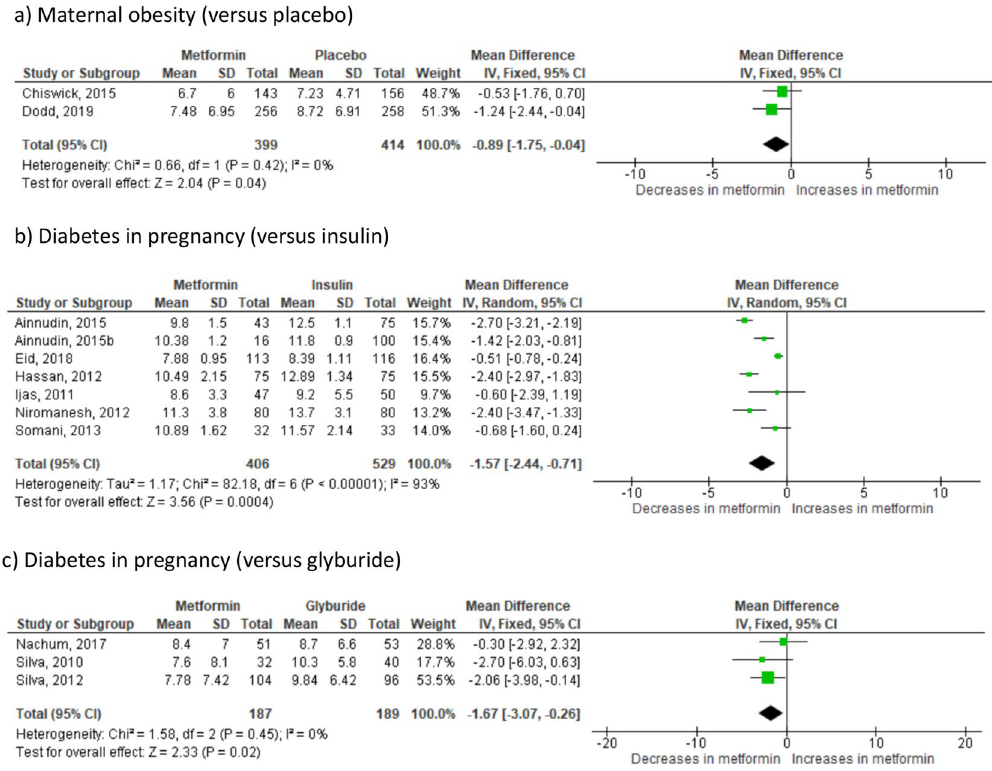
Figure 1. Effect of metformin randomisation upon gestational weight gain (throughout pregnancy); (all indications), based on 14 studies including 3004 pregnancies. Mean difference IV, random-effects model, 95%